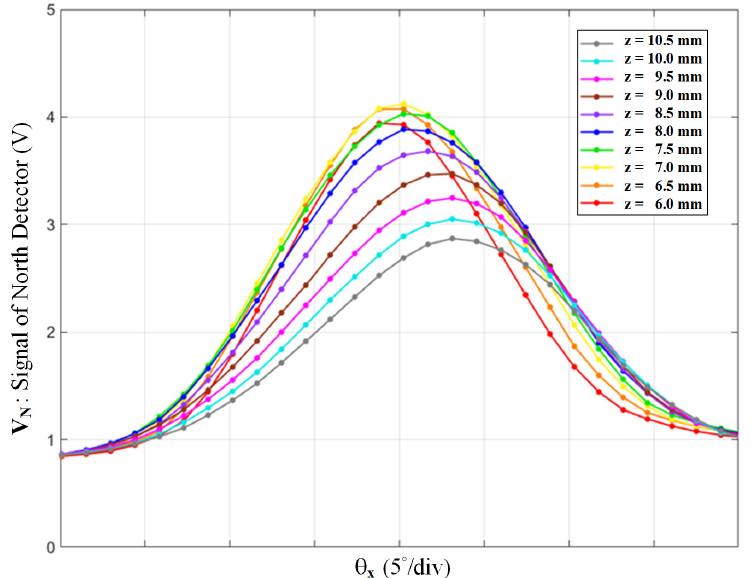
Figure 7. The north detector’s signal over θ x , with different values of the PCB-mirror distance.